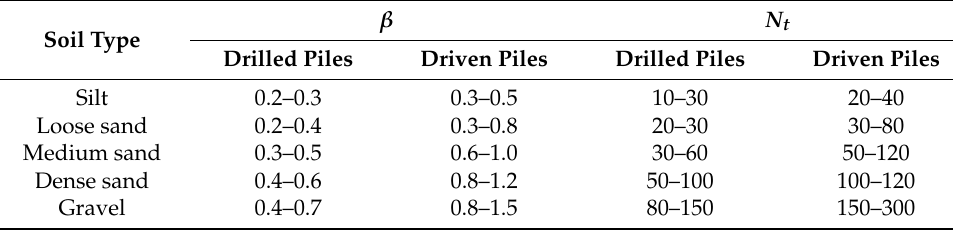
Table 1. β and N t values, according to CFEM, for driven and drilled (bored) piles [14].